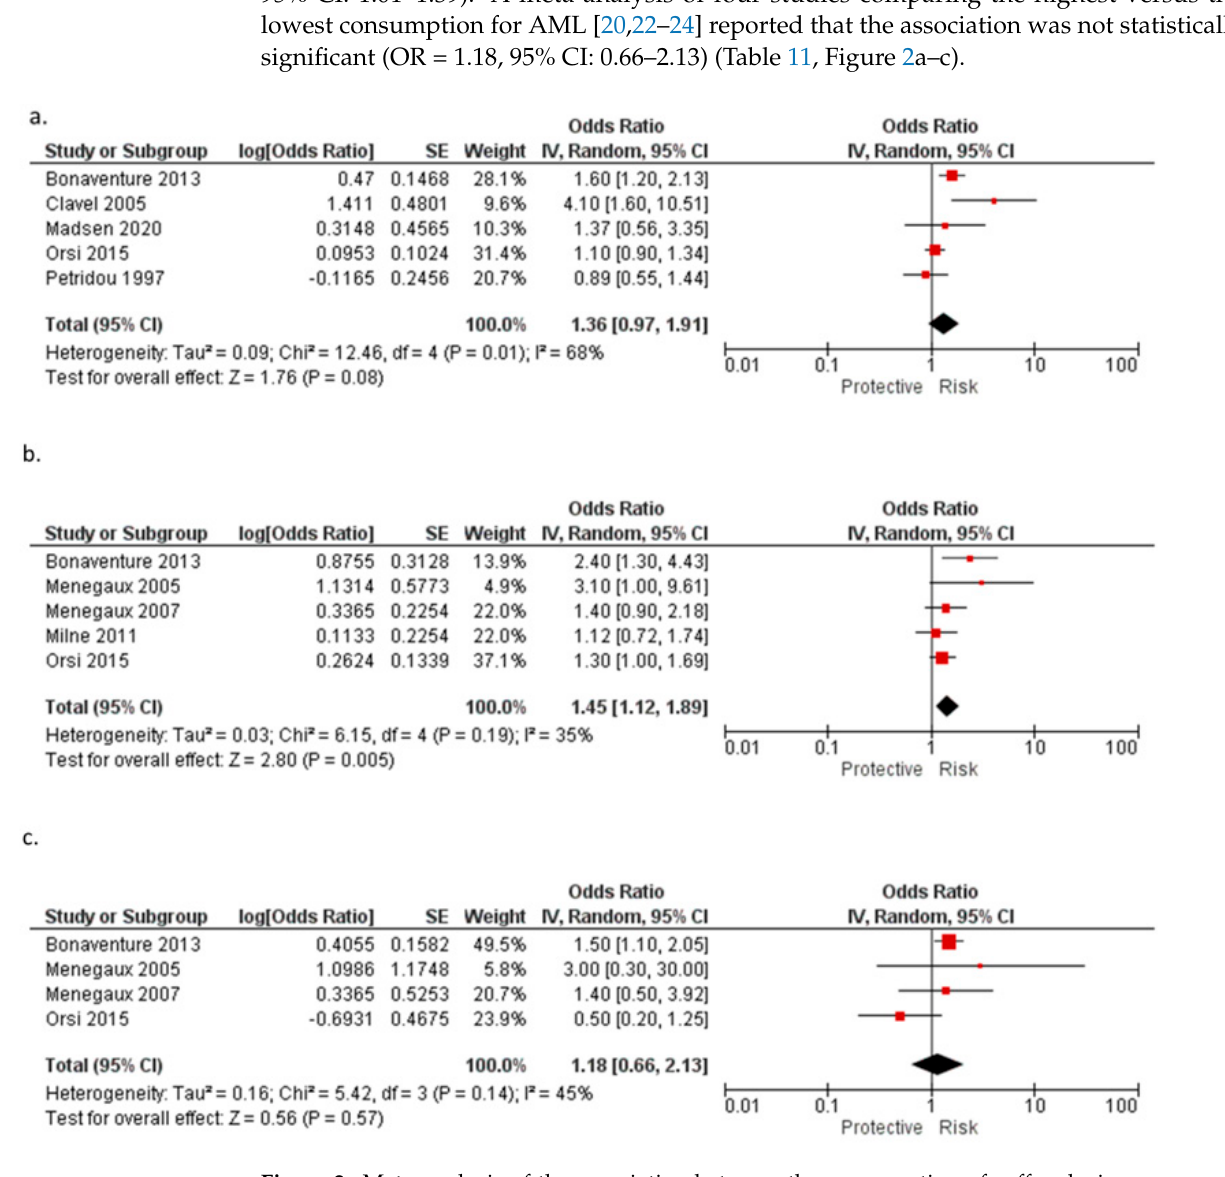
Figure 2. Meta-analysis of the association between the consumption of coffee during pregnancy and ( a ) acute leukemia, ( b ) acute lymphoblastic leukemia and ( c ) acute myeloid leukemia. Note: and ( a ) acute leukemia [22,24–27], ( b ) acute lymphoblastic leukemia [20–24] and ( c ) acute myeloid the individual estimate (OR) from the studies are represented by the red box, and the black dia- leukemia [20–22,24]. Note: the individual estimate (OR) from the studies are represented by the red mond represents the estimate of the meta-analysis. box, and the black diamond represents the estimate of the